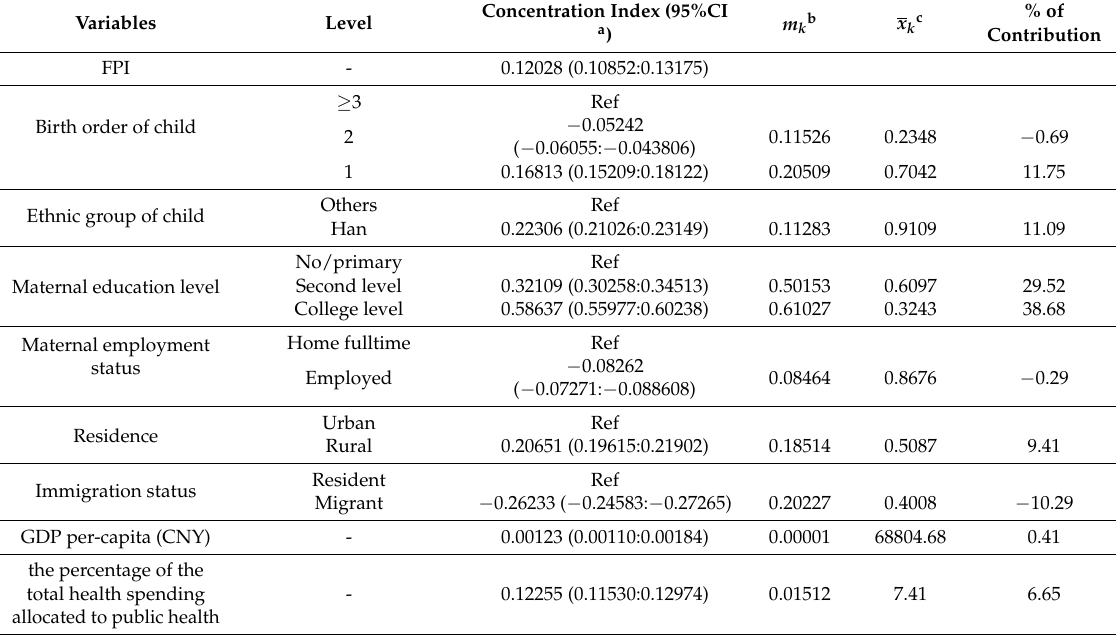
Table 2. The concentration index and contributions of determinants to inequities in the coverage of FPI in the 2014 coverage survey.